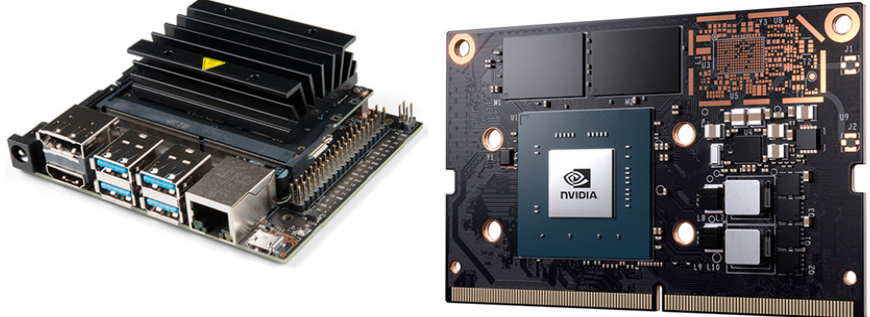
Figure 18. The NVIDIA mini-system—the Jetson Nano system on module (SOM; under the radiator) is detailed to the right.